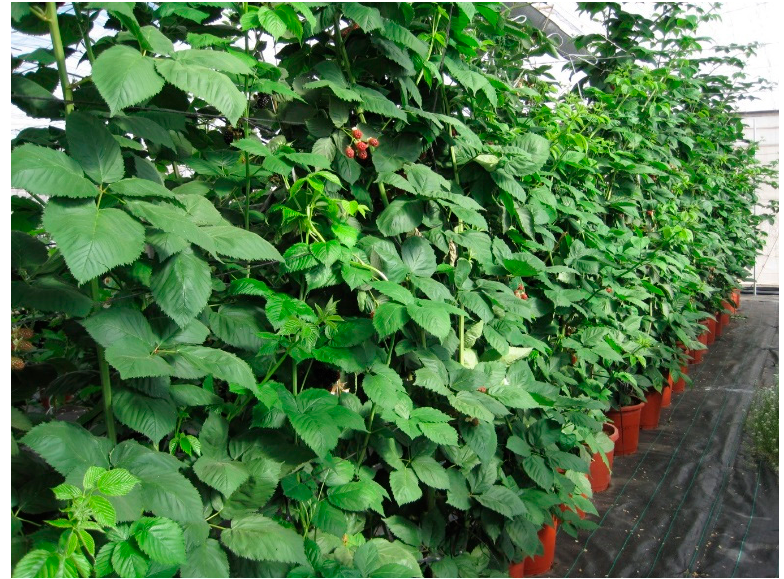
Figure 6. Trial of Tupy blackberry variety growing in greenhouse.